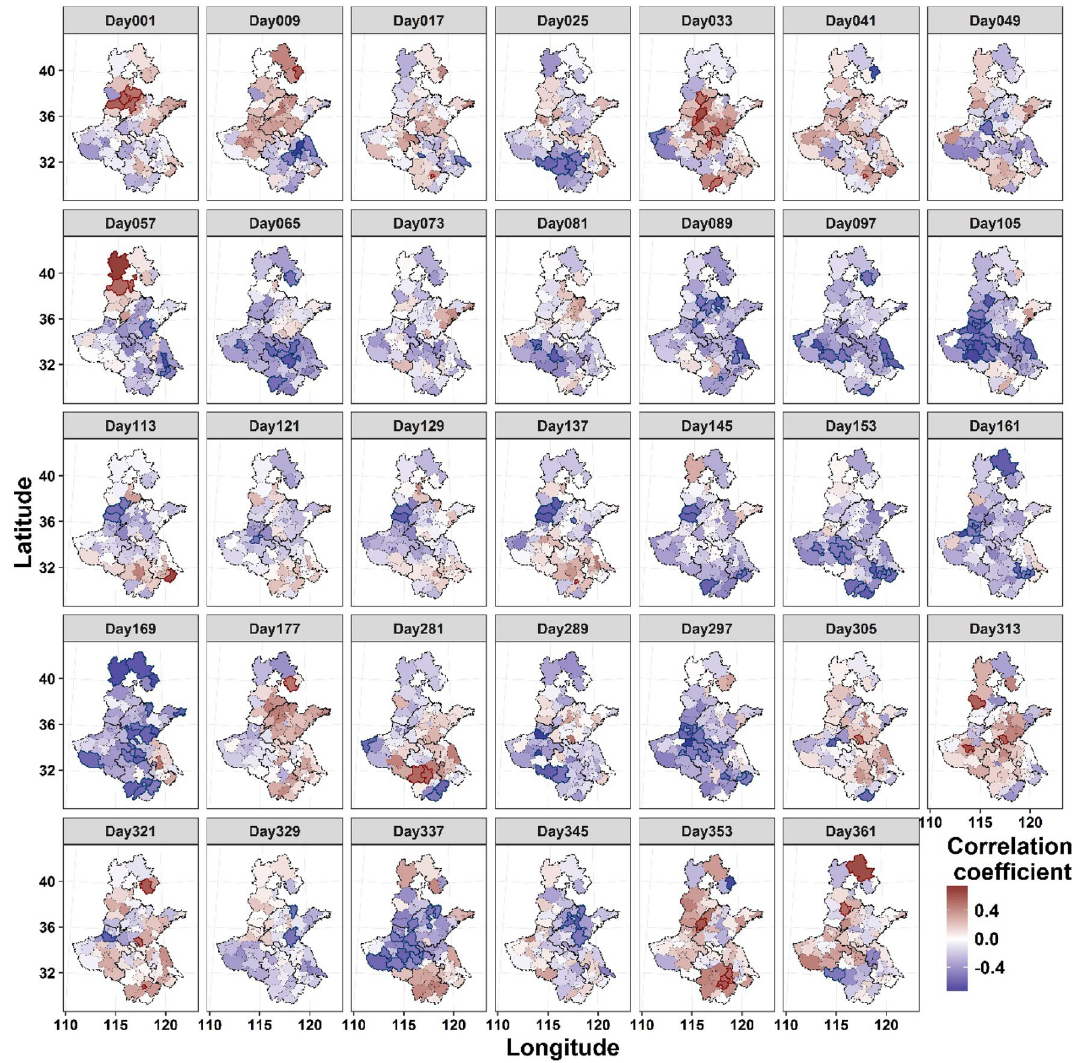
Fig. 6 Spatial pattern of correlations between incipient drought-affected crop area and winter wheat yield in Anhui, Hebei, Henan, Jiangsu, and Shandong Provinces, China,